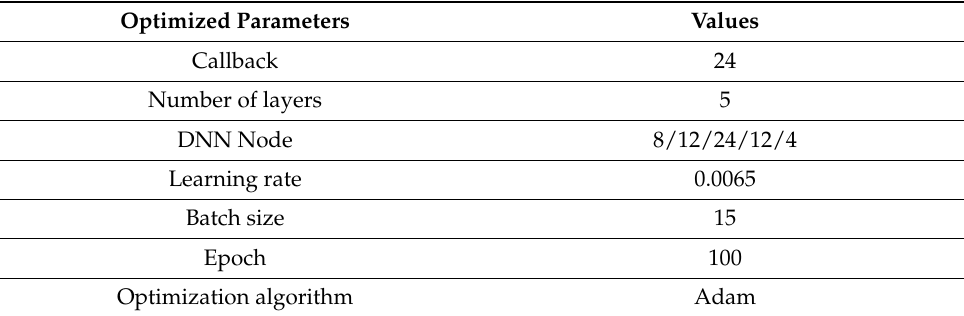
Table 2. Results of hyper-parameter optimization for